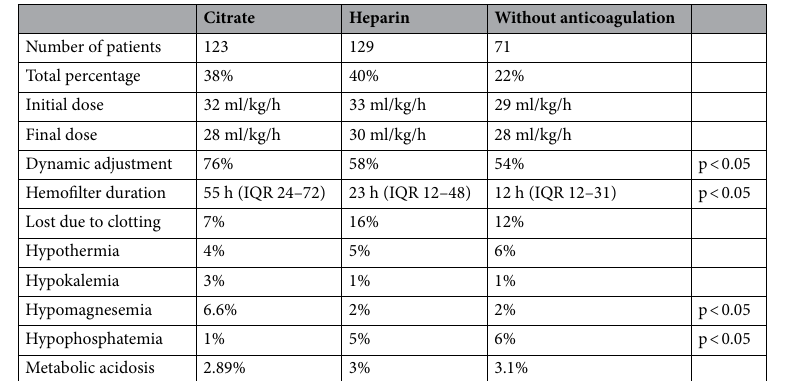
Table 2. Characteristics and complications of CRRT by anticoagulation